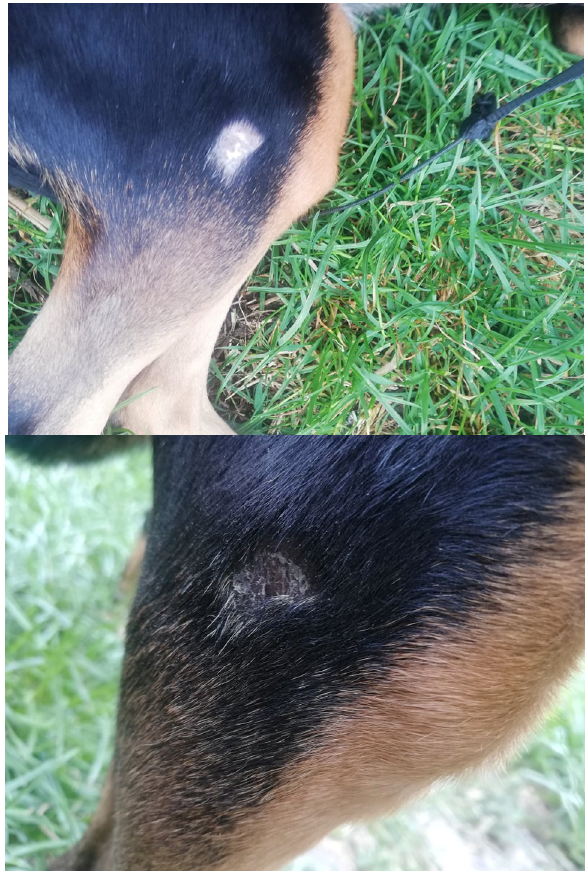
Figure 3. Treatment results of patient 3 with SILVER STOP ® cream. Patient 4. SS ® cream was prescribed for application twice daily for 15 days. At the end of the period, there was an absence of crusts, folliculitis, and erythema. New hair growth was observed (Figure 4).